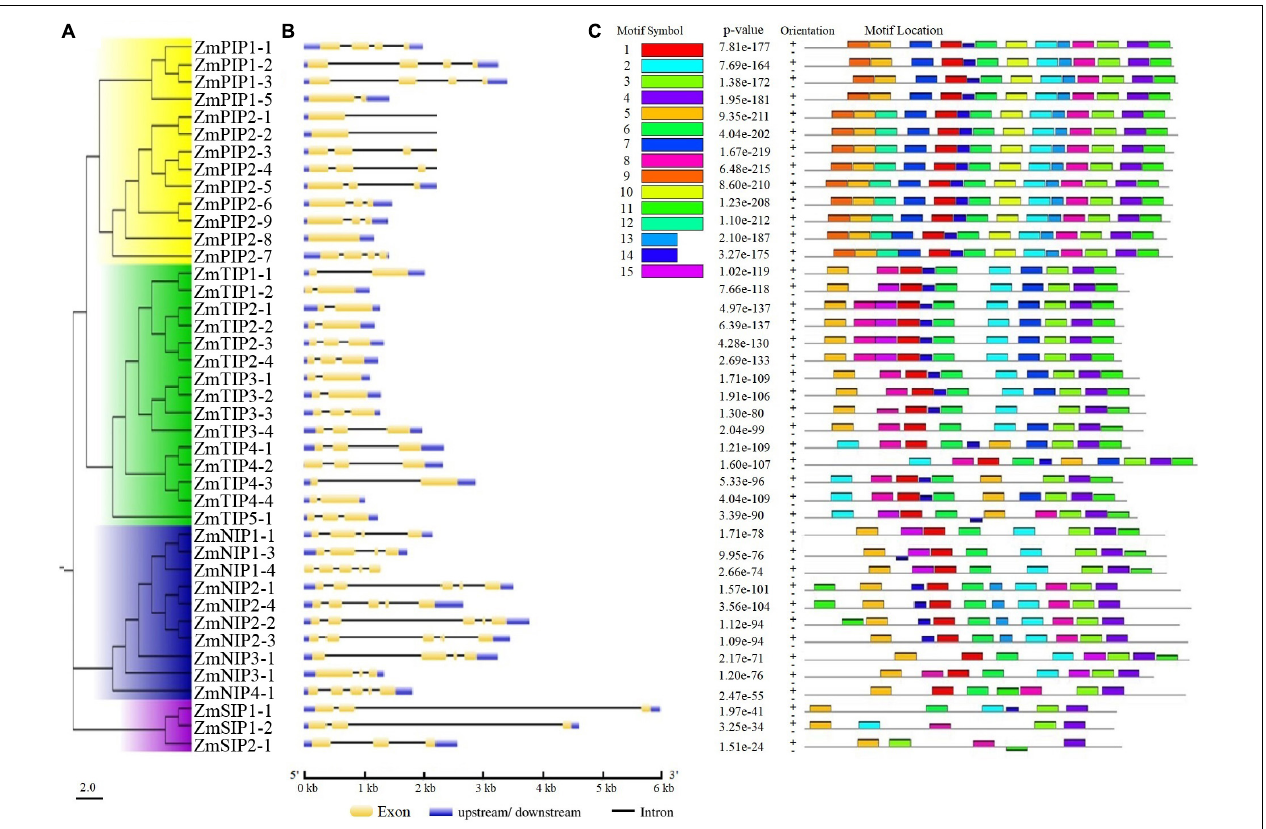
FIGURE 2 | Phylogenetic relationships, gene structure and motif compositions of ZmAQPs. (A) The neighbor-joining evolutionary tree of 41 ZmAQP protein sequences constructed using MEGA X software. The details of four subfamilies are shown in different background colors. (B) Exon-intron gene structure of ZmAQP genes. Exons (CDS) and introns are represented by yellow boxes and black lines, respectively. Blue boxes indicate the upstream or downstream regions of genes. Gene length is shown in kb on the x-axis. (C) Distribution of conserved motifs in ZmAQPs. The conserved motifs were identified using the MEME online program. Different motifs, numbers 1–15, are highlighted with different colors. The sequence information for each motif is provided in Supplementary Table 2